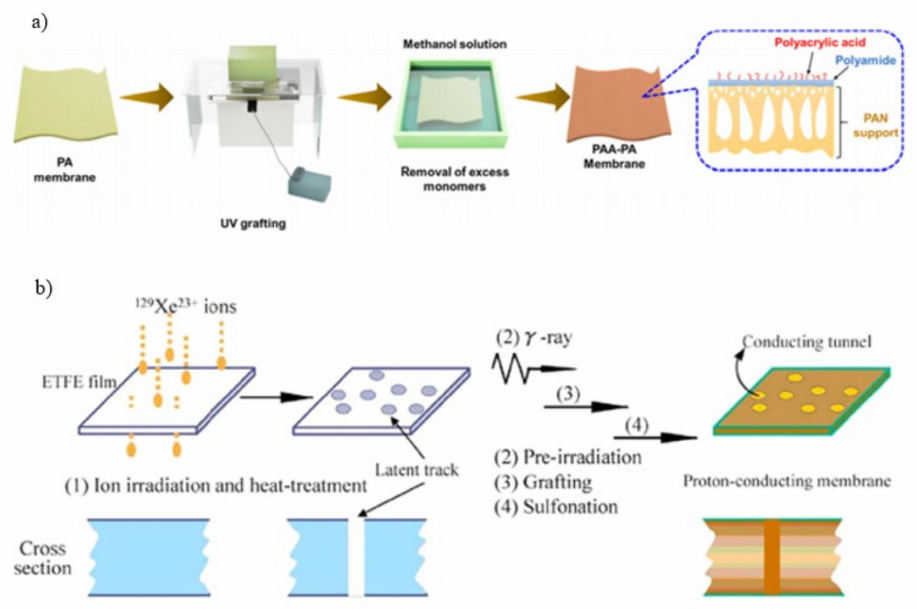
Figure 4. Schematic representation of ( a ) Preparing UV-grafted composite membrane [98]; ( b ) Irradiation-initiated graft polymerization on membranes